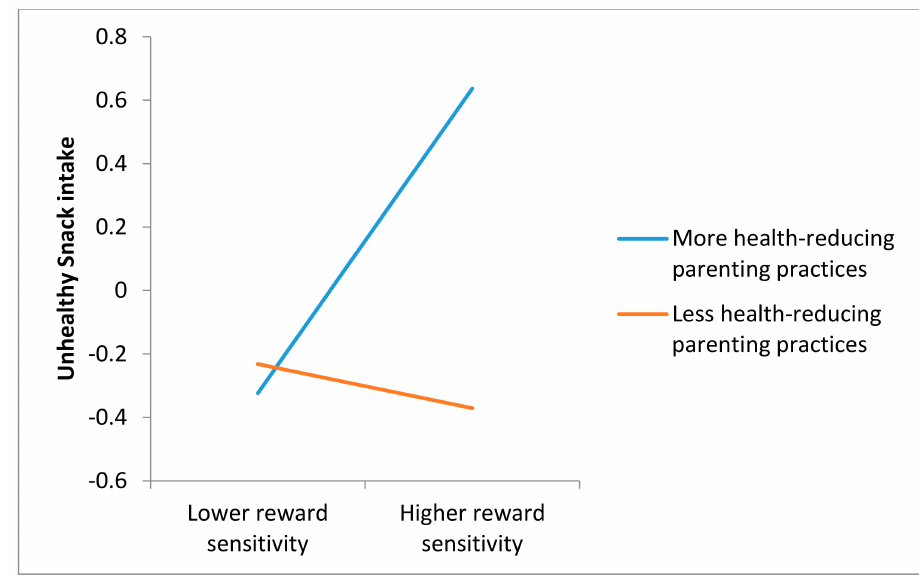
Figure 1. The moderation e ff ect of Reward Sensitivity and Health-reducing parenting practices on the intake of unhealthy